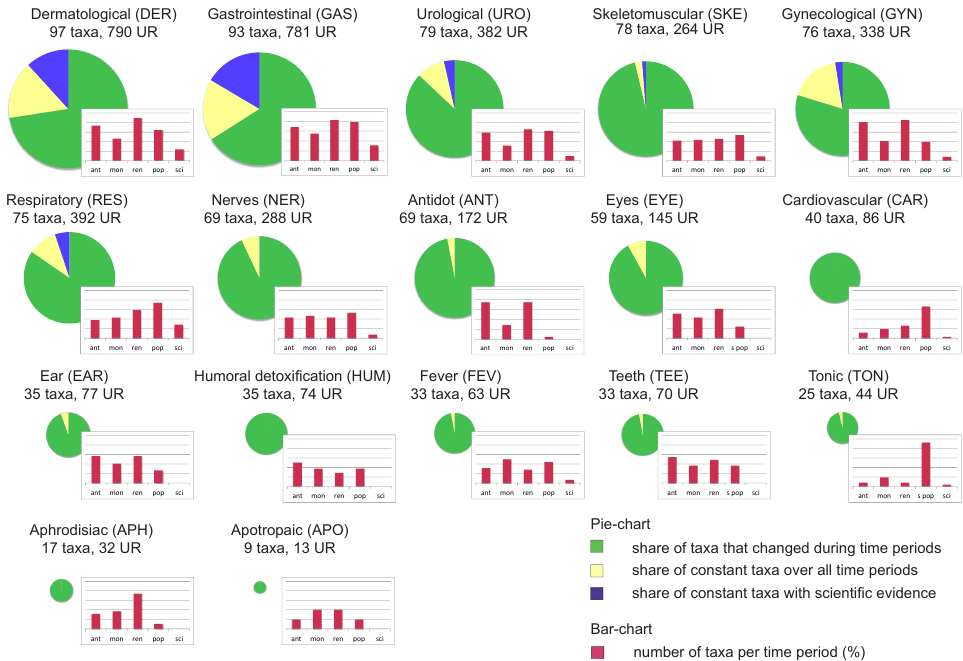
Figure 2. Pie charts show the total number of taxa used for a specific use category. Bar charts show the percentage of total taxa used in different